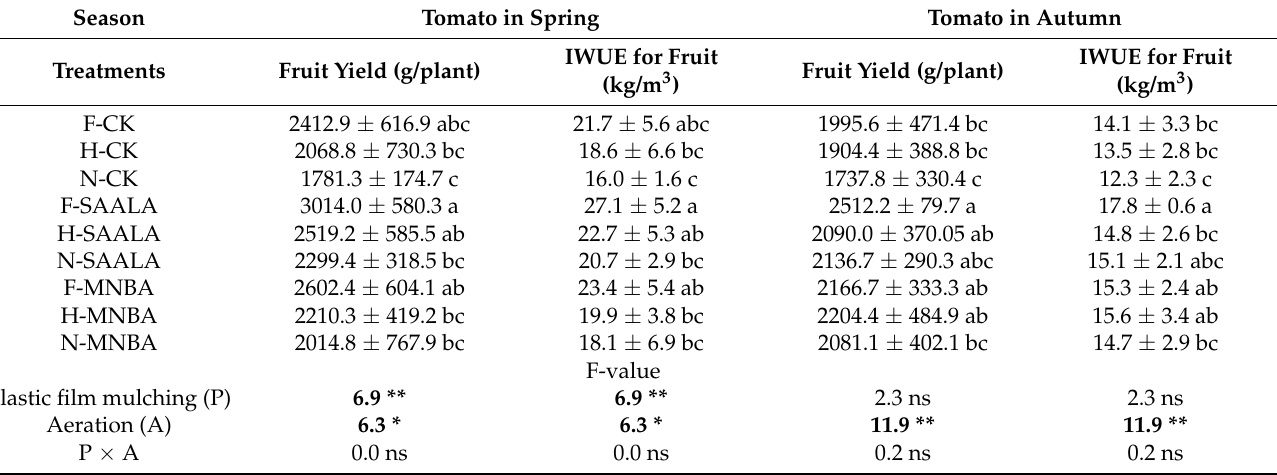
Table 3. Effects of different aeration treatments on fruit yield and irrigation water-use efficiency (IWUE) of